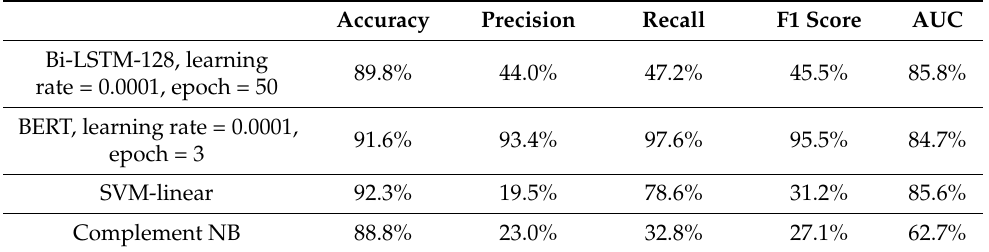
Table 4. Performance among Bi-LSTM, BERT, SVM, and NB on the test set. Accuracy Precision Recall F1 Score AUC Bi-LSTM-128, learning rate = 0.0001, epoch =